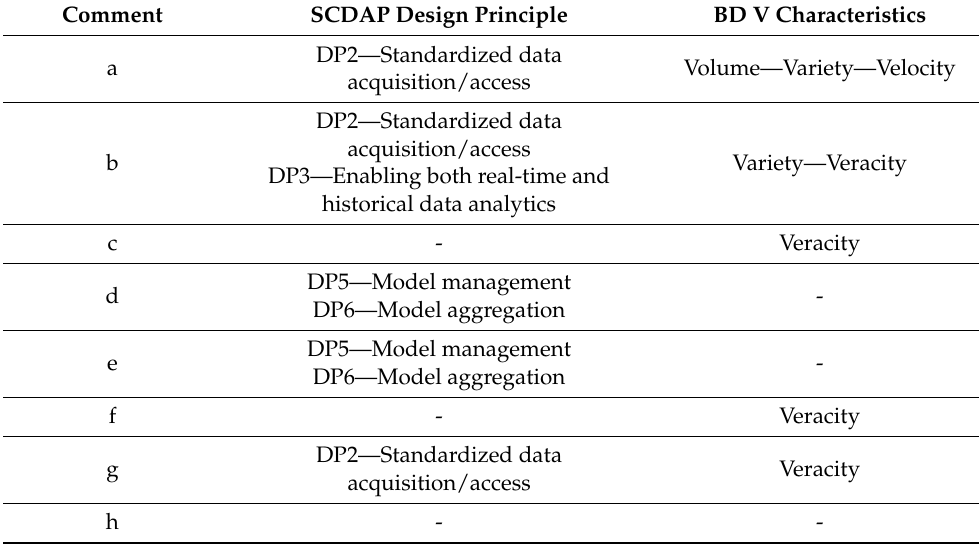
Table 3. Projection of end-user feedback into SCDAP design principles and BD